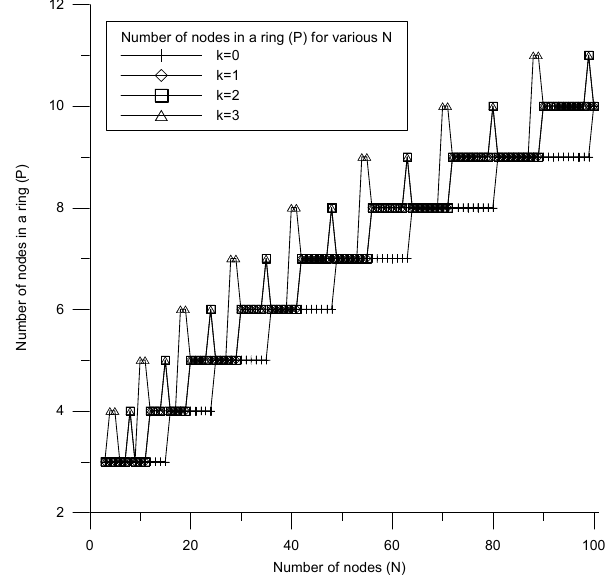
Figure 6. Optimal number of nodes in a ring for various N .